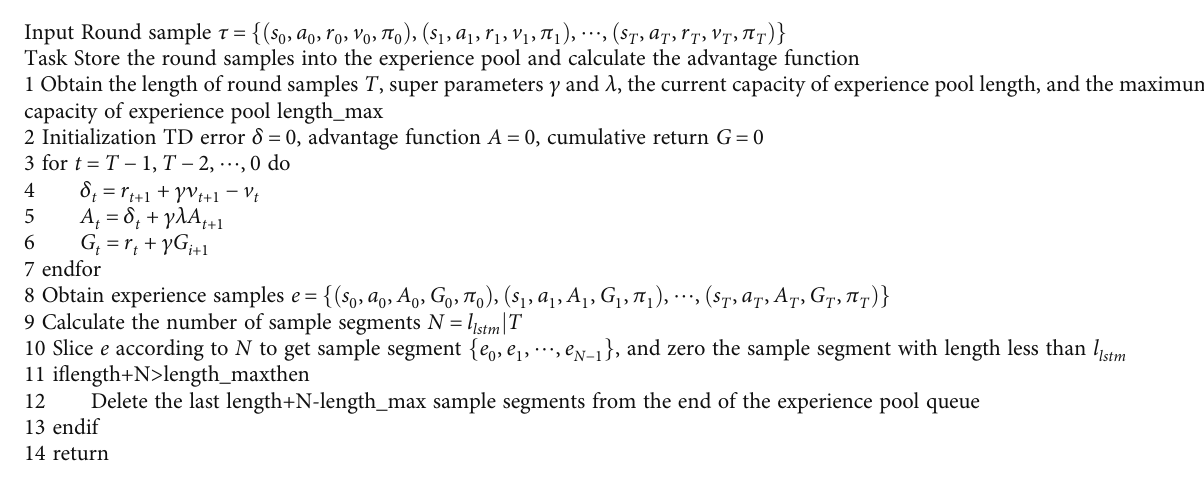
Algorithm 2: Experience pool storage